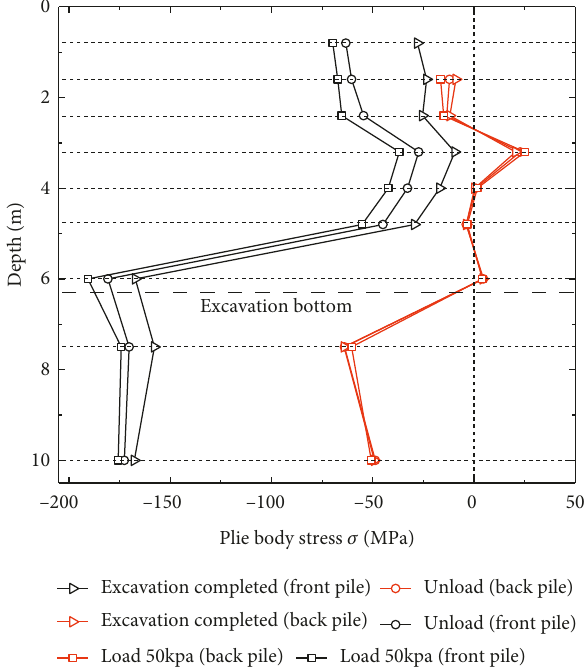
Figure 12: Comparison of stress distribution of pile in excavation completed, loading, and unloading